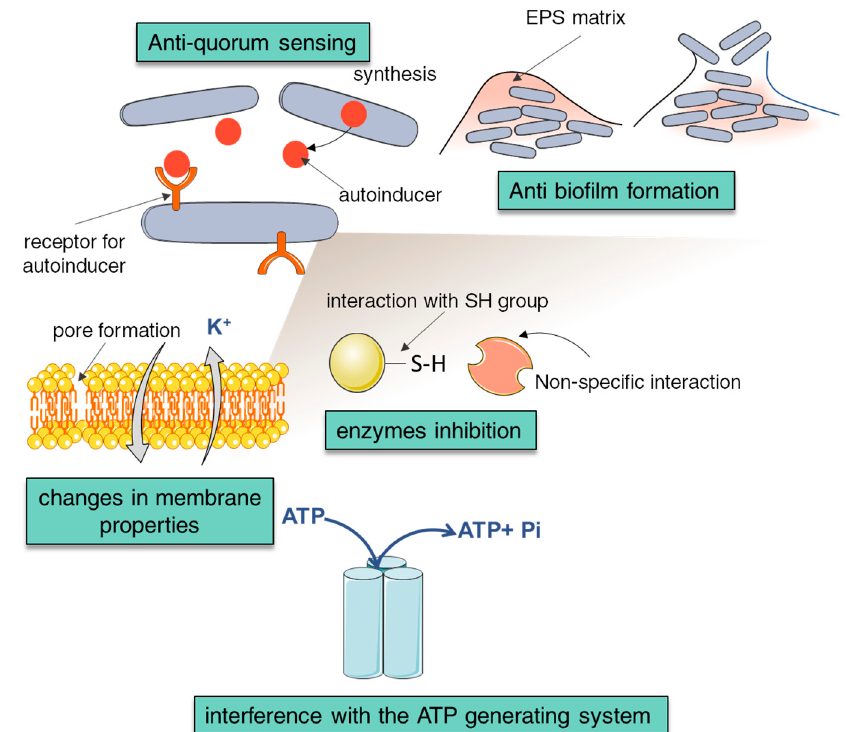
Figure 2. Selected mechanism of antimicrobial action of plant-derived carboxylic acids. [Based on [131]] Anti-quorum sensing. The quorum-sensing communication system can be inhibited in several di ff erent ways: Inhibition of autoinducers synthesis and transport, antagonist activity for autoinducers-receptors, and also direct reaction or inhibition of autoinducer activity. Changes in membrane properties. Phenolic acids (especially hydrophobic compounds) a ff ect the properties of cell membranes (charge, permeability) through changes in hydrophobicity, reduction of negative surface charge, and the formation of pores in the membranes and leakage of intracellular components [135,136]. Anti-biofilm formation. Limiting the formation of biofilm by phenolic acids involves limiting cell adhesion to the surface and inhibiting biofilm maturation, indirectly through anti-quorum sensing action and inhibition of the expression of genes involved in biofilm formation [137,138]. Interference with the ATP generating system. Phenolic acids, by increasing the permeability of cell membranes, leak ions and partially inhibit the activity of ATPase [139] and other proteins, including enzymatic (enzymes inhibition). Acids with strong nucleophilic properties (e.g., CA) can donate an electron pair to electrophilic functional group of plasma membrane proteins and lipids leading to the membrane destabilization [140].